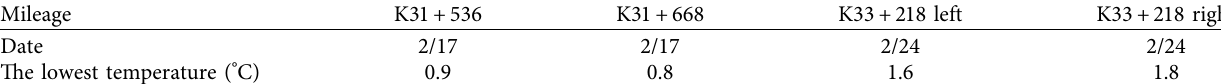
Table 3: Minimum temperature of testing sections.